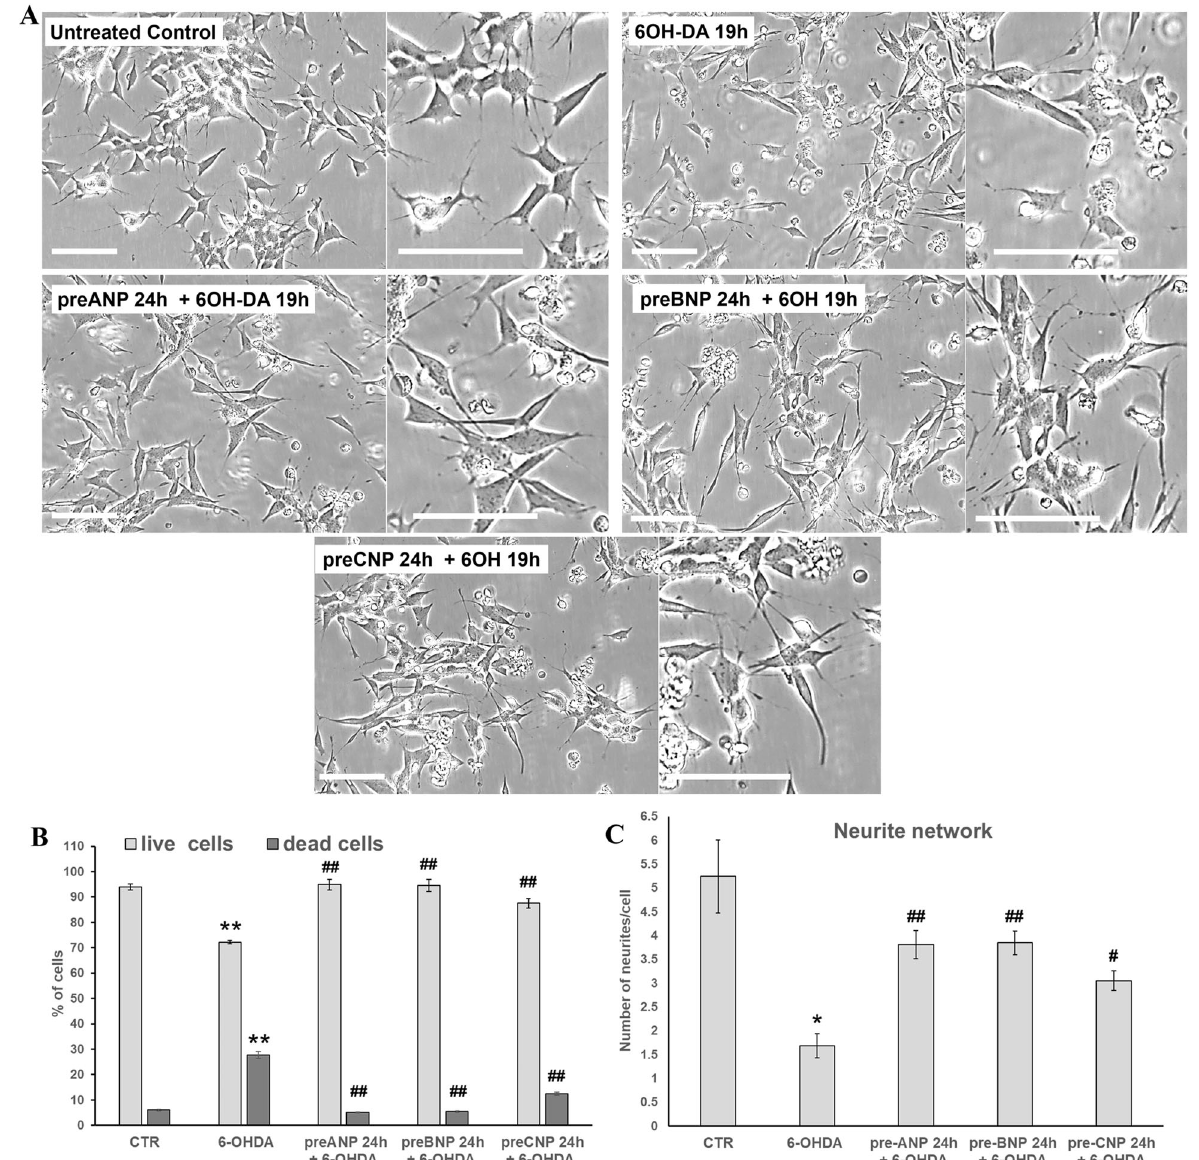
Fig. 2 NPs pre-treatment prevents 6-OHDA toxicity in SHSY5Y cells. A Phase contrast microscopy of SHSY5Y cells was exposed to 50 µM of 6-OHDA for mimicking the neurodegeneration of PD. To assess the neuroprotective ability of NPs against 6-OHDA induced cytotoxicity, cells were pre-treated with 100 nM of the hormones 24 h prior to 6-OHDA addition to the cell culture medium. Bars 100 µm. B Cell viability assay performed on SHSY5Y cells after 19 h of 6-OHDA treatment by Trypan blue dye exclusion method; results reported as a percentage of live/ dead cells, are mean ± SD from three independent experiments ( n = 3). Signi fi cance (one-way ANOVA test + Tukey post-test): * vs. untreated control (CTR), # vs. 6-OHDA; ** p < 0.01, *** p < 0.001. Additional results from the one ‐ way ANOVA test used to analyze the differences between groups are reported in Supplementary Data. C Quantitative assessment of the protective effect exerted by NPs on neurite network performed on phase-contrast microscopic images, by counting the number of neurites/cell in treated and untreated SHSY5Y cells. A minimum of 300 cells/sample has been analyzed and results were reported as mean values ± SD from three independent experiments. Signi fi cance (two-tailed Student ’ s t test) * vs. untreated control (CTR), # vs. 6-OHDA; * p < 0.05, ** p <